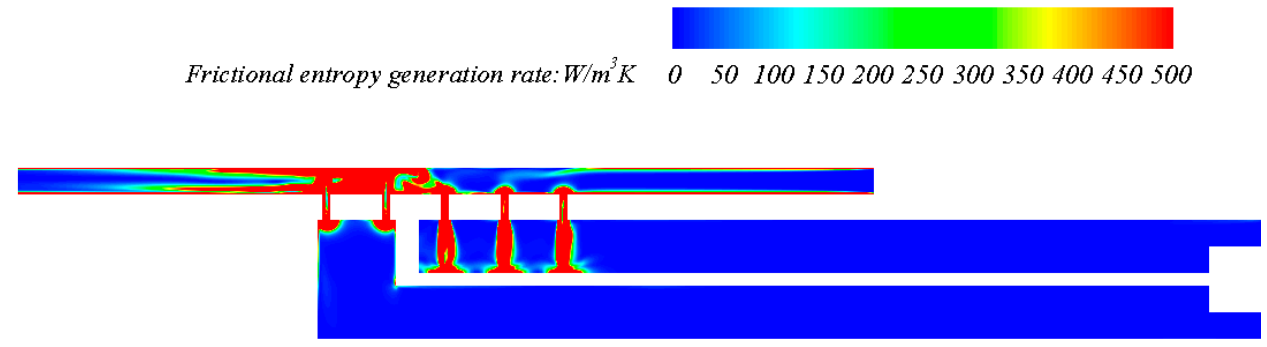
Figure 18. Frictional entropy generation rate in the fluid domain ( x = 28.5 mm, 0.75 T of DSJ on).